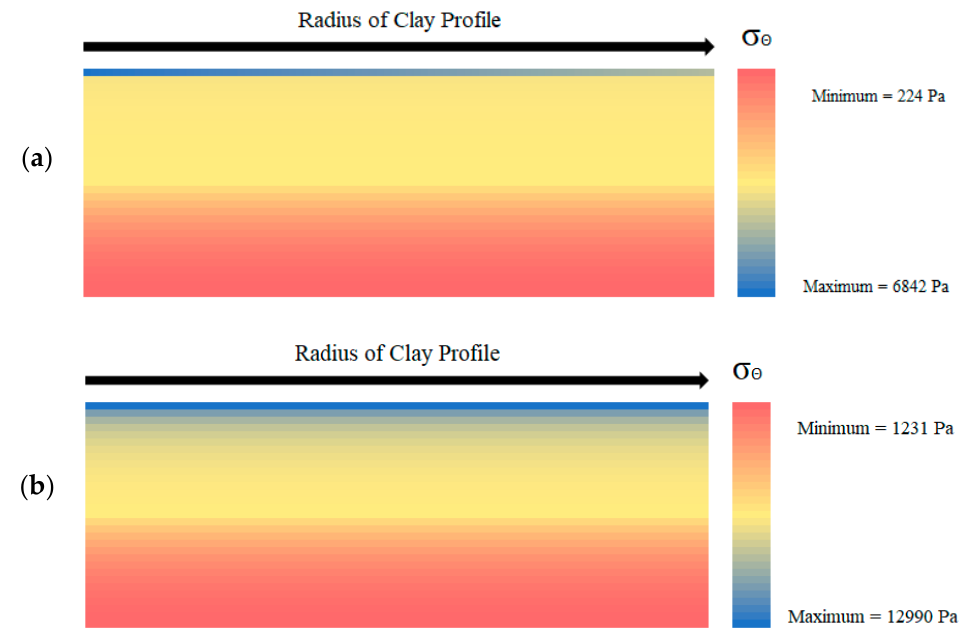
Figure 13. Hoop stress across the soil profile at the time of crack initiation for the ( a ) untreated and ( b ) xanthan-gum-treated